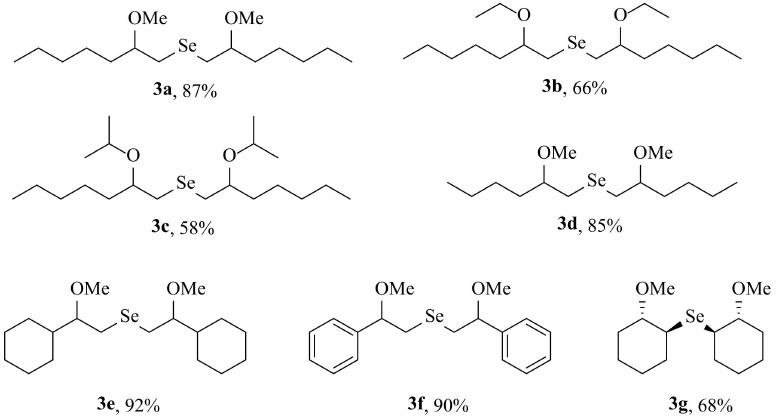
Figure 3. Scope of selenides 3 *. * A total of 3.5 mmol alkene 1a – e , 1 mL of alcohol, 1 mmol